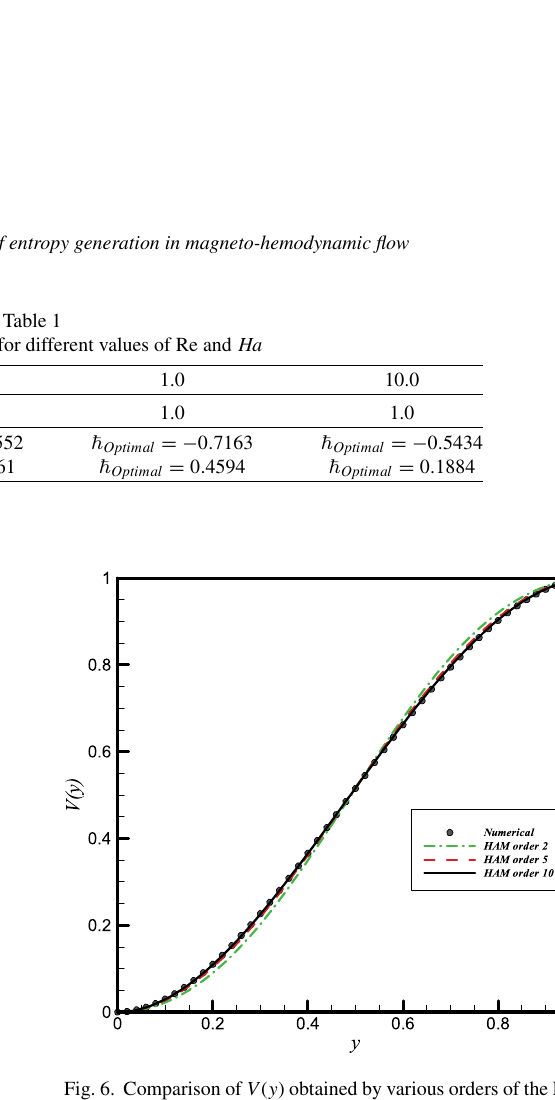
Fig. 6. Comparison of V ( y ) obtained by various orders of the HAM with numerical solution, when Re = 1 . 0 and Ha = 1 . 0 , [45].